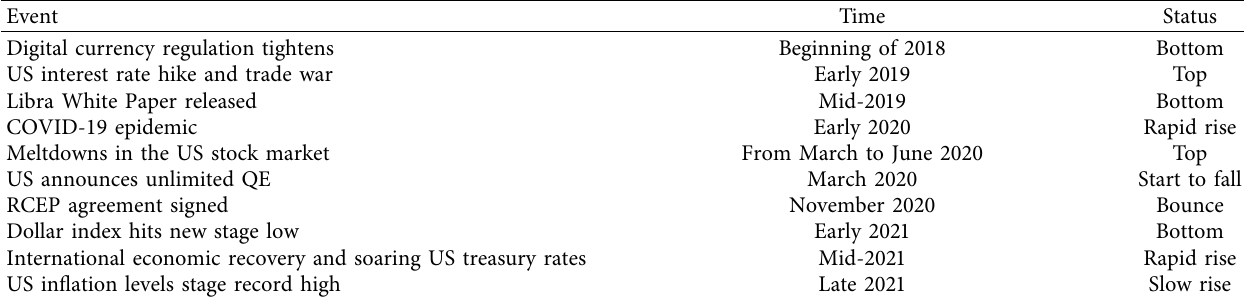
Figure 1: Total connectedness. This figure illustrates the changes in the total connectedness of the four digital currencies. The events corresponding to the trend changes are also labelled. Table 2: Event-driven table (here are the event-driven cases of total connectedness; from left to right are the events, corresponding time, and the status of total